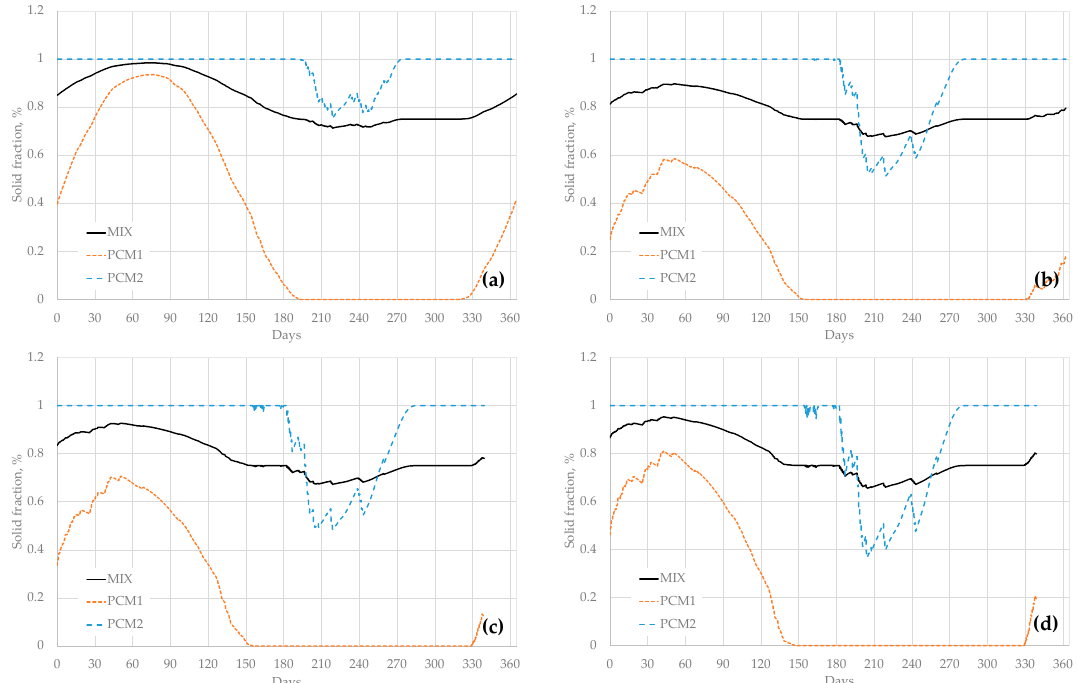
Figure 12. Solid phase fraction of the PCM components and overall mixture (MIX) in the trench. ( a ) DP01, ( b ) DP11, ( c ) DP11*, ( d ) DP11+.